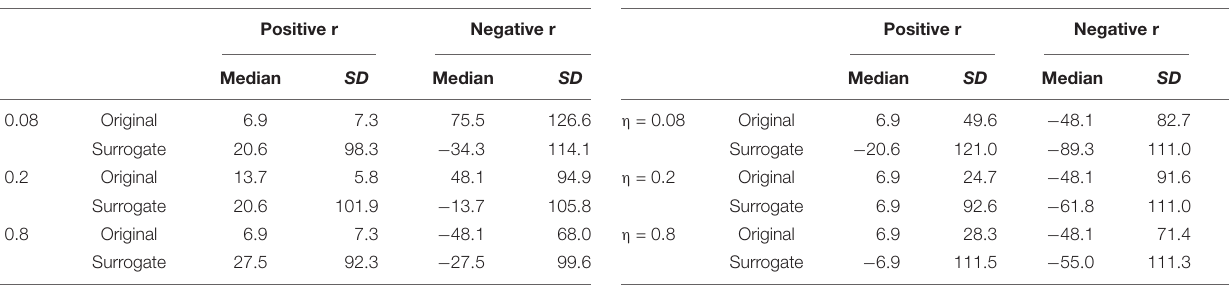
TABLE 2 | Medians and standard deviations (across speakers) of the lag (in ms) at which the highest positive and negative correlations are found between MBEAM and MFCC